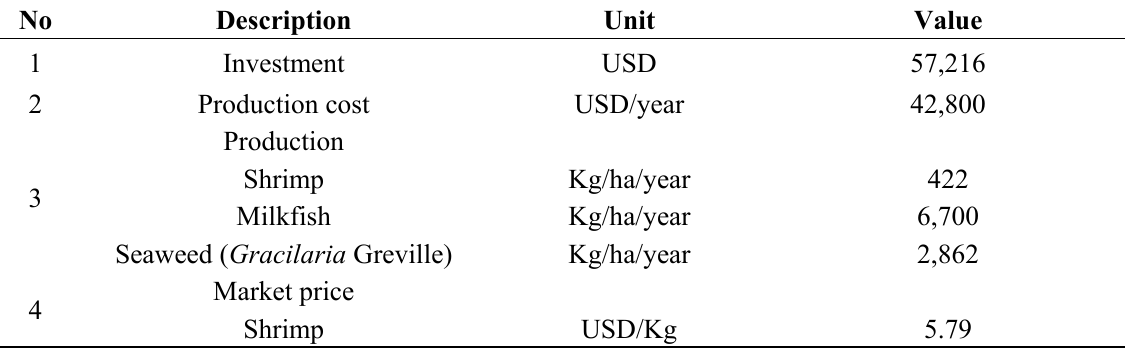
Table 6. Benefit value of commercial aquaculture in the Takalar district, South Sulawesi,